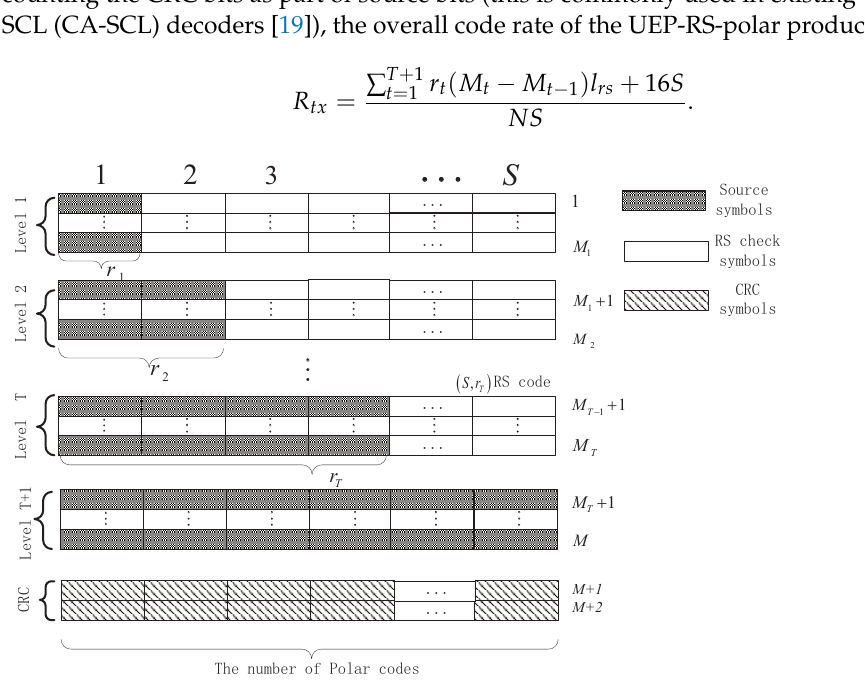
Figure 1. Structure of the proposed UEP-RS-polar product coding